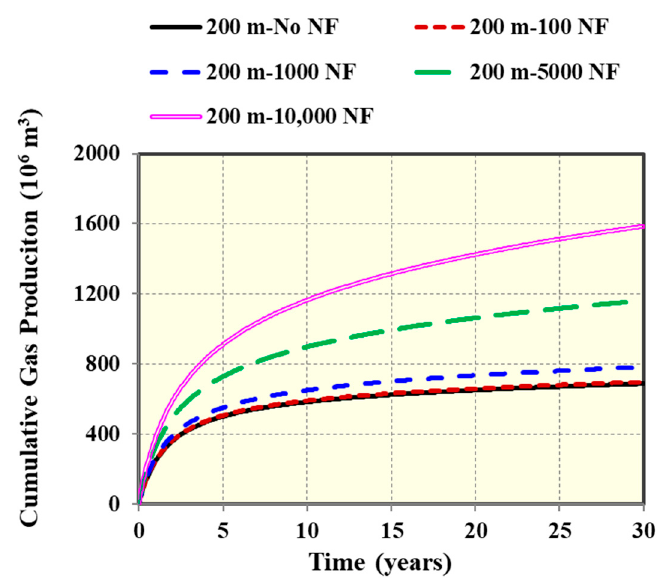
Figure 8. Effect of different numbers of natural fractures on cumulative gas production for the reservoir model with well spacing of 200 m (NF in the legend represents natural fractures).